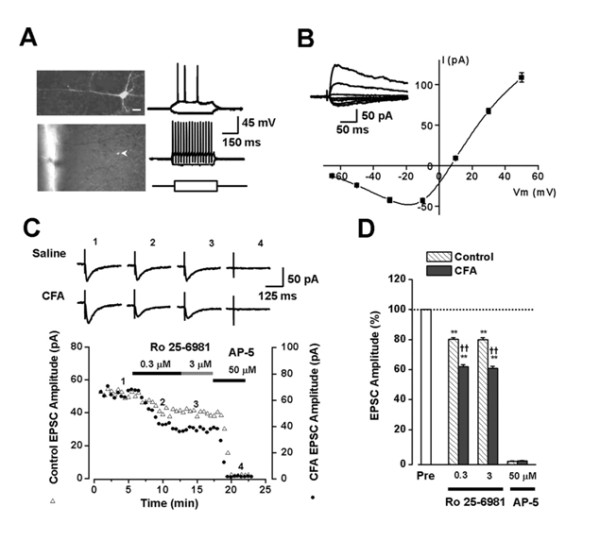
Inhibition of PKMζ selectively decreased the amplitude of eEPSCs in ACC neurons of mice with neuropathic pain by reducing the number of active AMPA receptors. A and B, Samples showed the effect of ZIP (5 μM) on the amplitude of eEPSCs in the ACC neurons of animals from the nerve injury [black circles in (A)] and sham group [black circles in (B)]. The gray open circles represent the change of membrane resistance during recording. Black traces in the upper part of (A) and (B) indicate the averaged response at baseline, and blue traces indicate the average of 2 min responses collected 10 min after ZIP application. C, Pooled data of effects of ZIP on the eEPSCs recorded from the ACC of mice in the sham (open) and nerve injury (solid) groups 10 min after ZIP application. *P < 0.05; error bars, SEMs (from Reference 32).